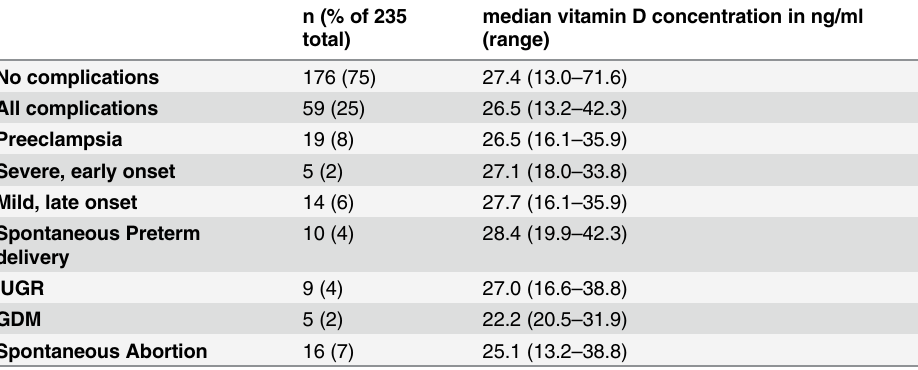
Table 3. Plasma vitamin D concentrations in women according to clinical outcome.